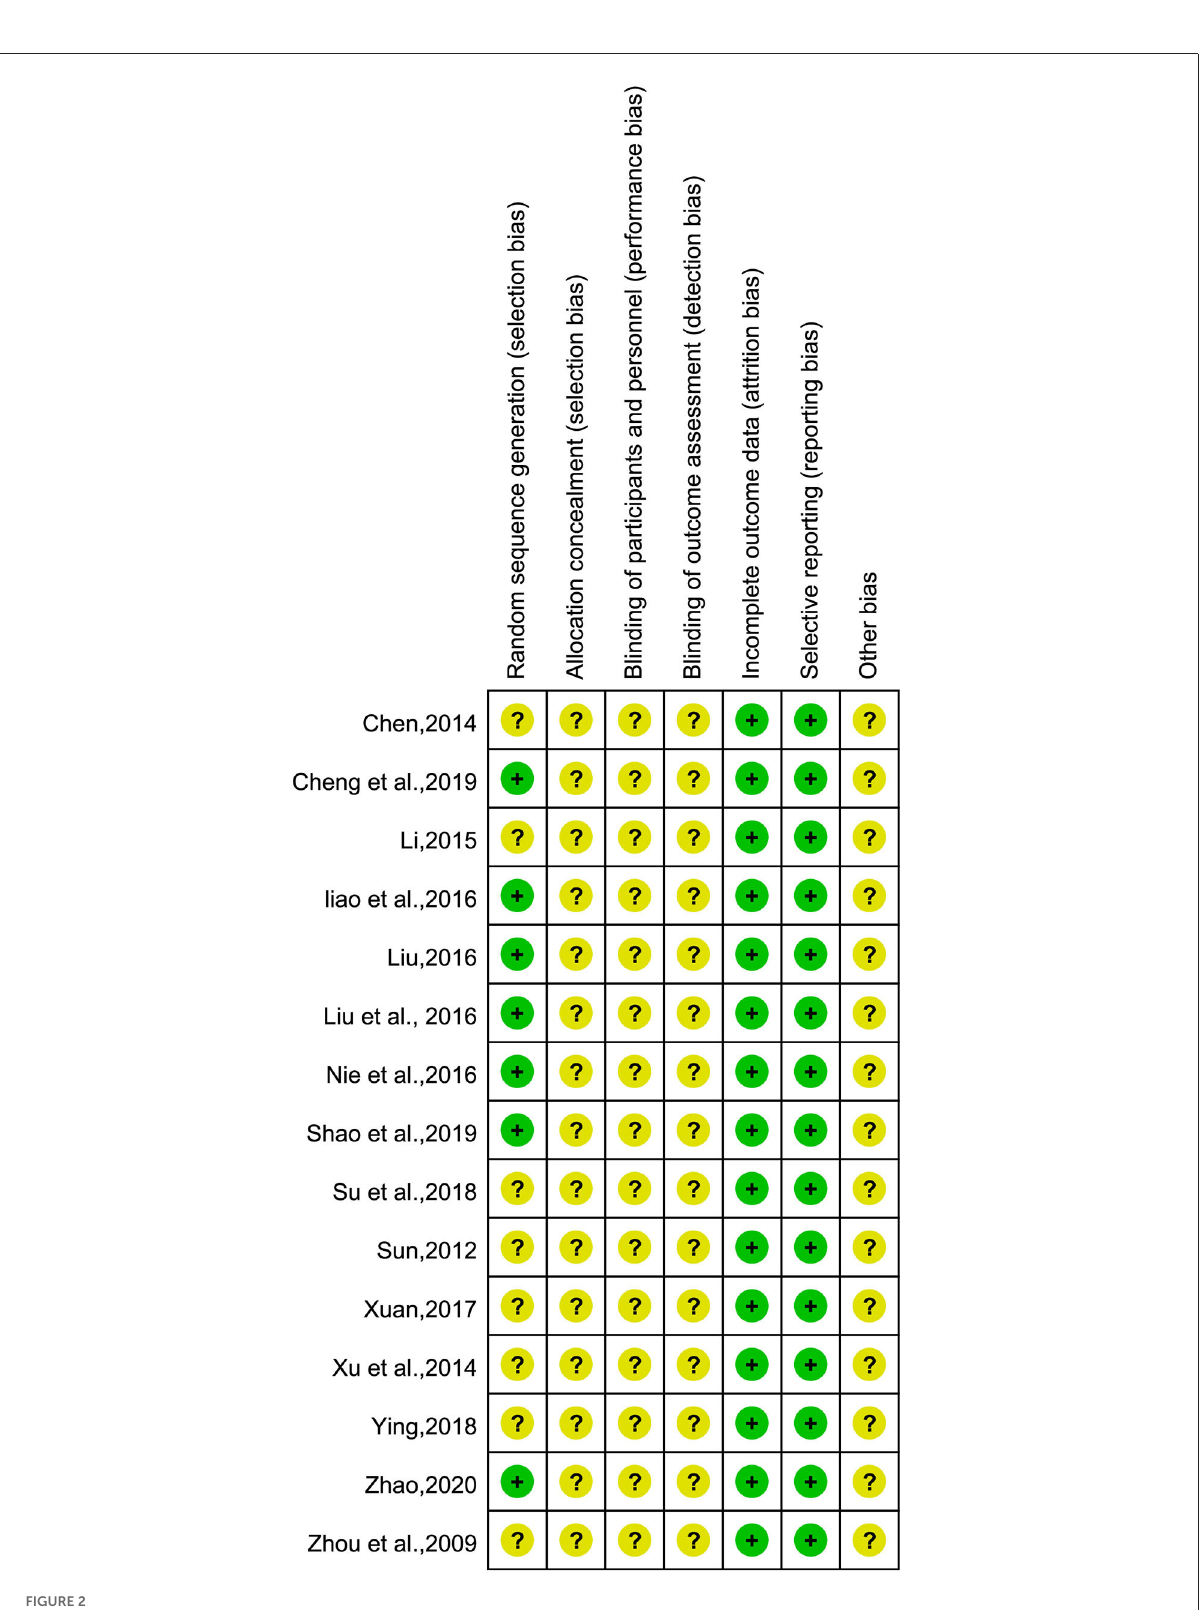
FIGURE2 Summary of risk of